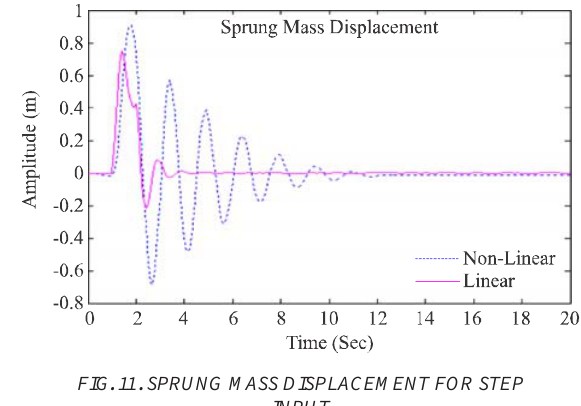
FIG. 11. SPRUNG MASS DISPLACEMENT FOR STEP INPUT